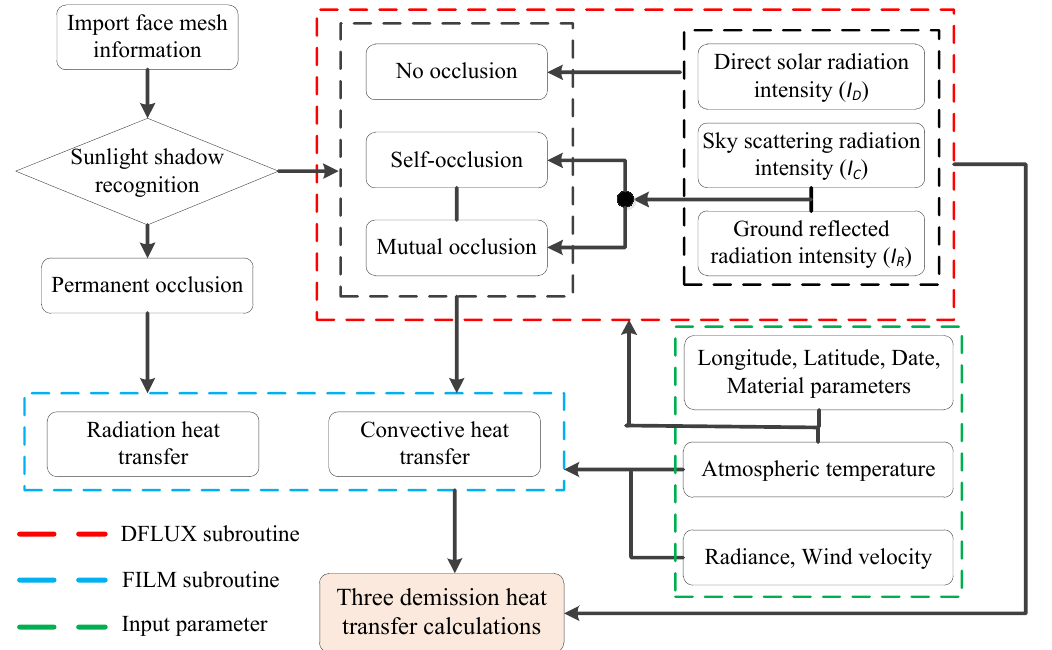
Figure 10. Three- dimensional sunshine temperature field analysis process. Figure 10. Three-dimensional sunshine temperature field analysis process.